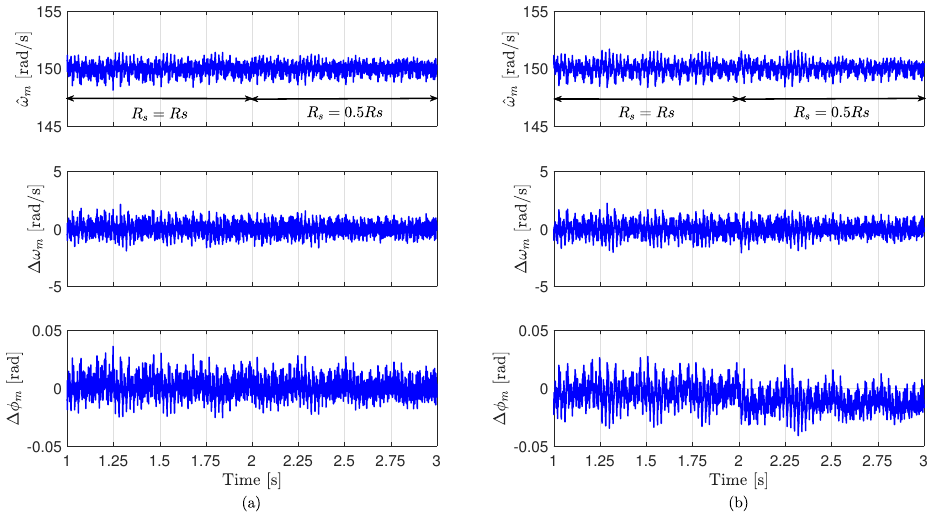
Figure 7. Experimental results at variations of the DFIG stator resistance R s : ( a ) LPS-MRAO, and ( b ) traditional MRAO.